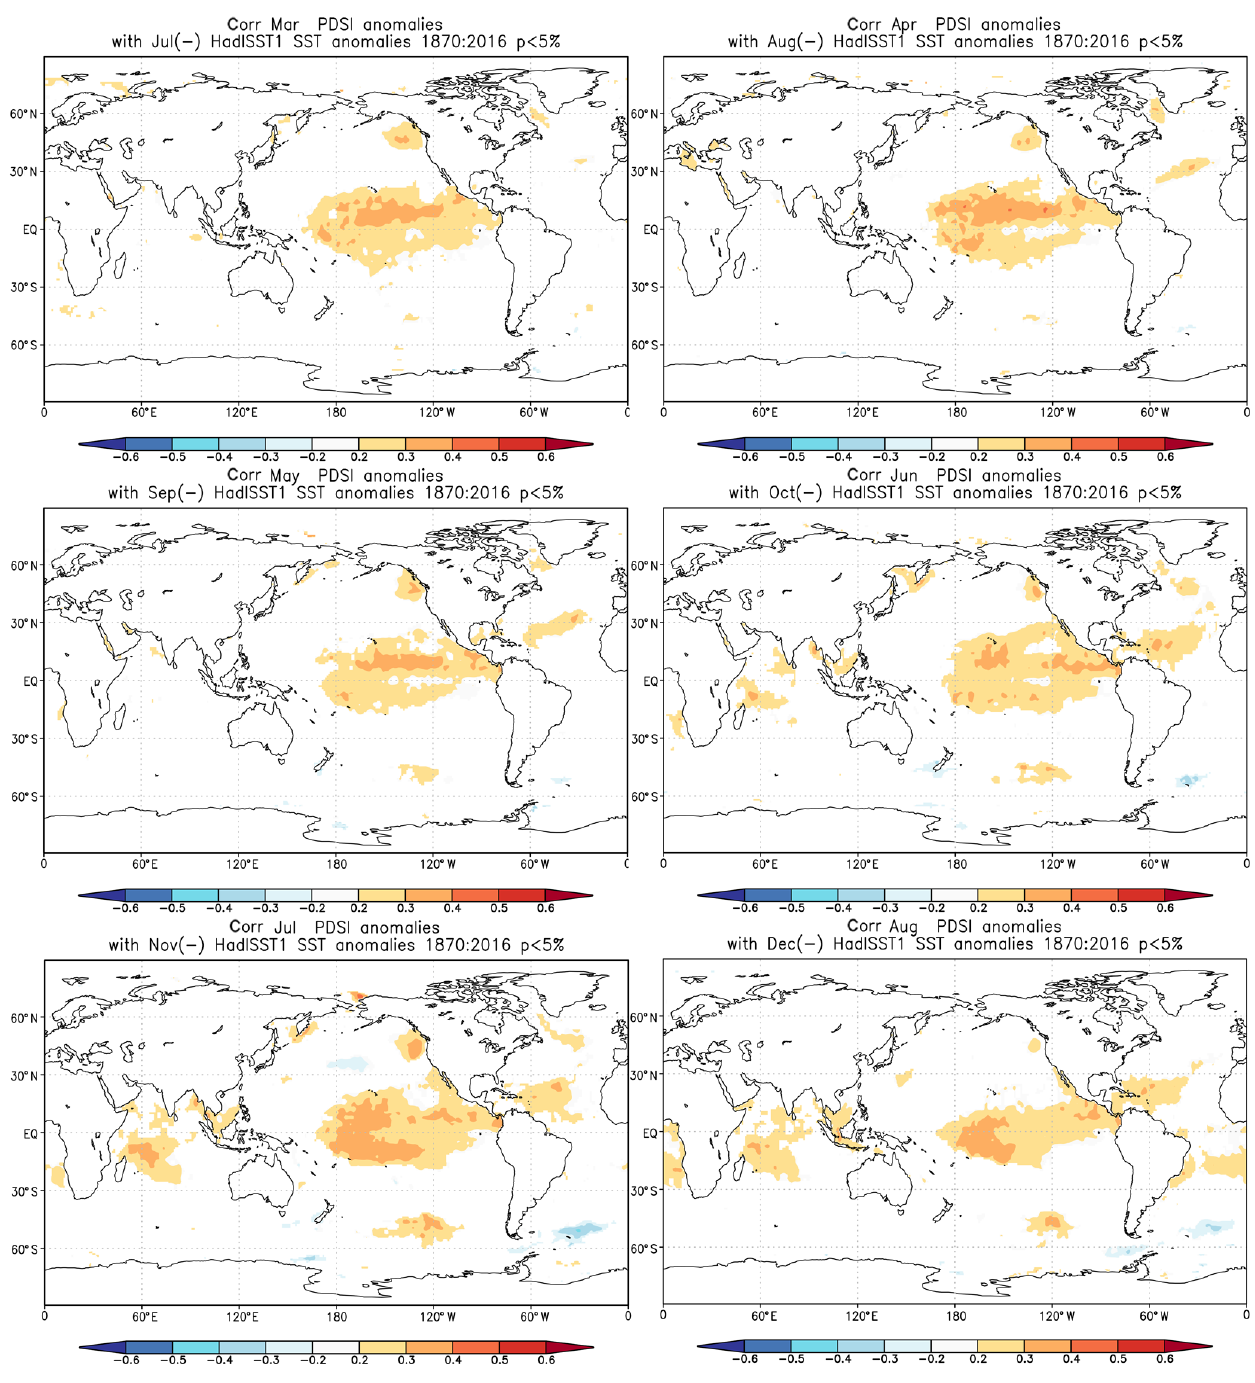
Figure 10. The field correlation between the monthly HadISST1 sea surface temperature and reconstructed PDSI with a lag of 8 months calculated by the KNMI Climate Explorer (1870–2016). The contours with p> 0 . 05 were masked